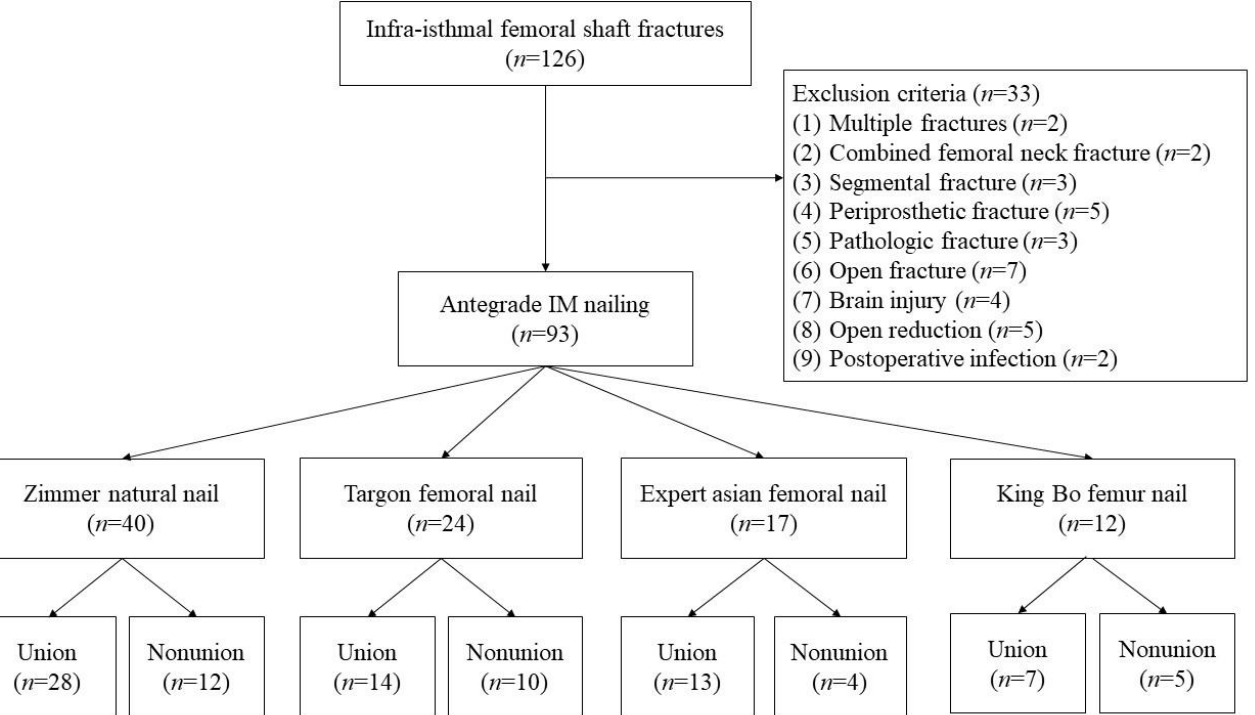
Figure 3. “Strengthening the Reporting of Observational Studies in Epidemiology” flowchart detailing the design of this study.